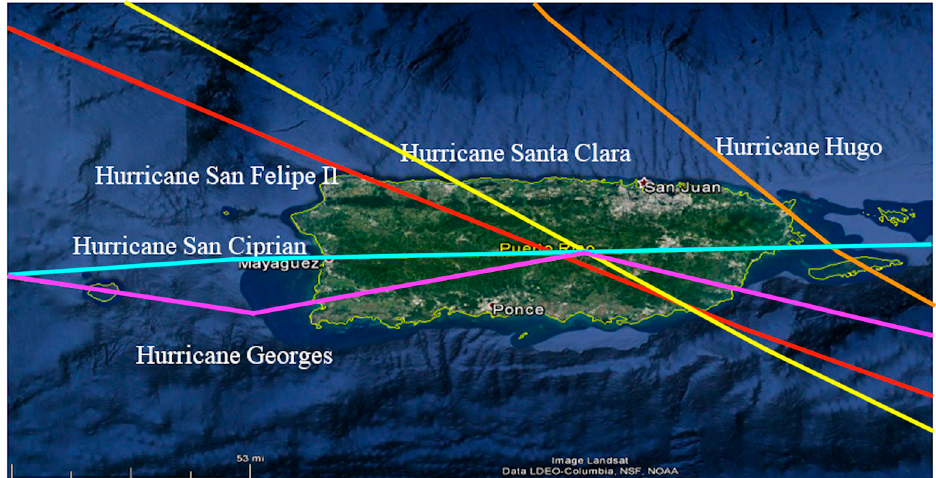
Figure 2. Track of the five most destructive hurricanes passing over Puerto Rico during the 20th century. The different colors represent different hurricane tracks. The name is next to each trajectory [12].